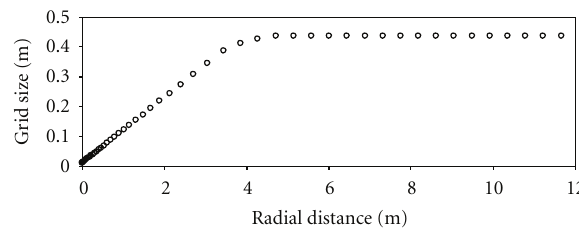
Figure 2: Variable grid size with radial distance for case 1.